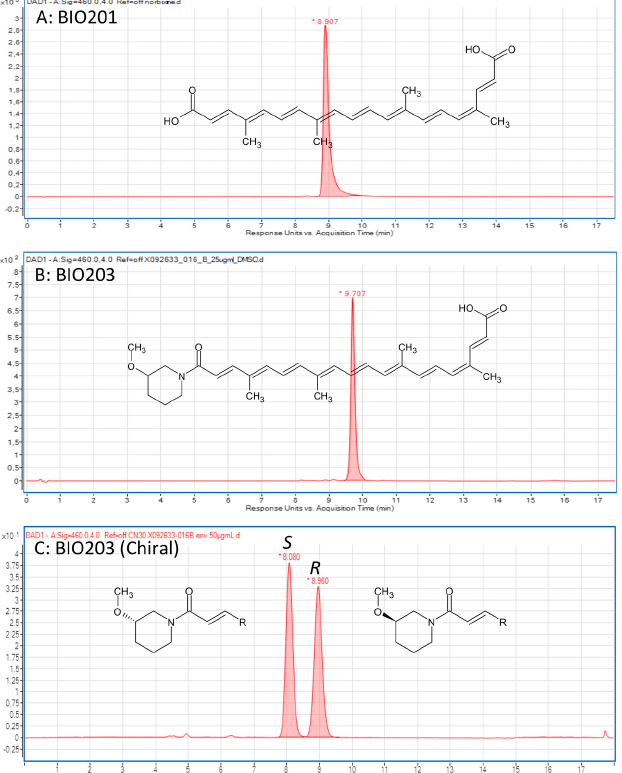
Figure 8. Structures and HPLC analysis of the compounds tested in the study. ( A ): Norbixin (BIO201) and ( B ) BIO203 structures and HPLC analysis showing their 97% and 98% purity, respectively. HPLC analytical conditions: Column Fortis C18 5 µ m (2.1*50 mm), flowrate 300 µ L/min, gradient from 35% to 100% of acetonitrile (+0.1% formic acid) in water (+0.1% formic acid) in 10 min,